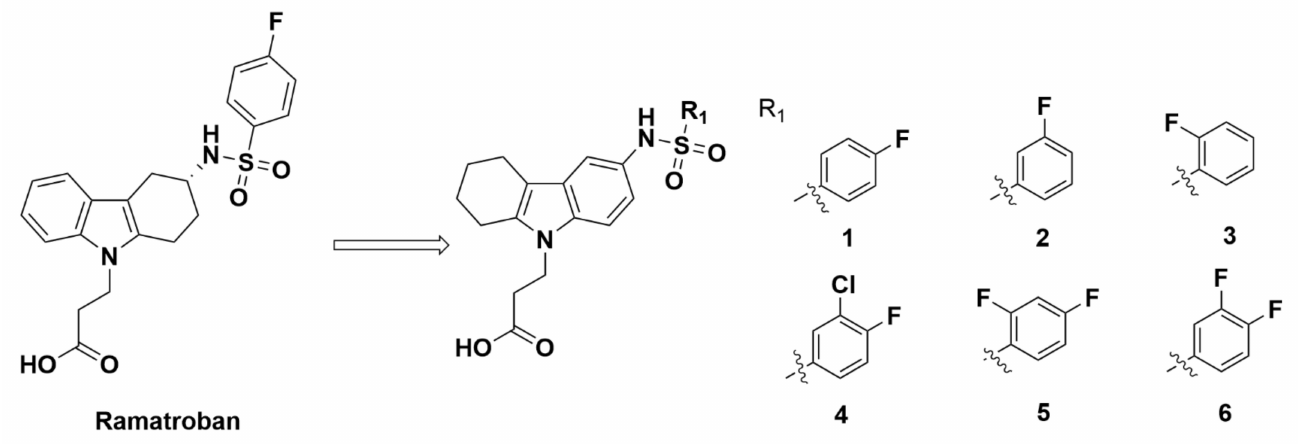
Figure 2. Molecular structures of compounds 1 – 6